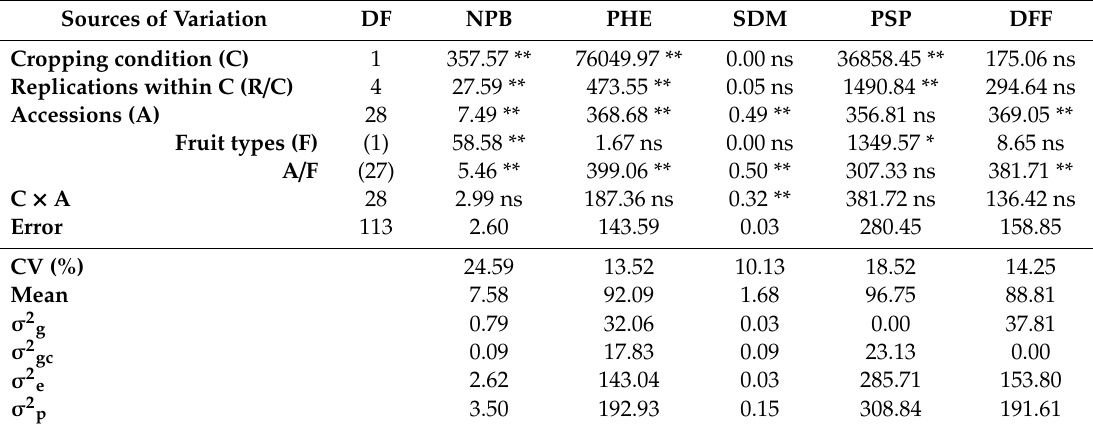
Table 4. Mean square of vegetative parameters of 29 eggplant